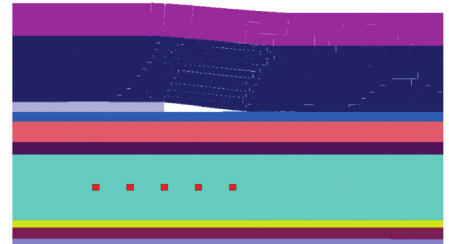
Figure 12: Layout of the measuring points in the stope.